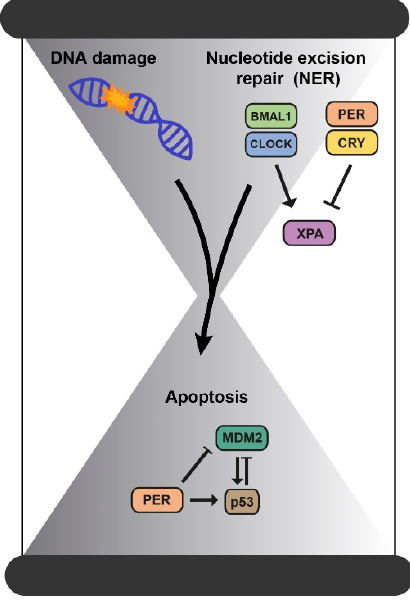
Figure 4. The connection between DNA damage and the molecular circadian clock. Accumulation of DNA damage and failures in the DNA repair mechanisms lead the cell to undergo apoptosis and all these processes are controlled by the circadian clock.